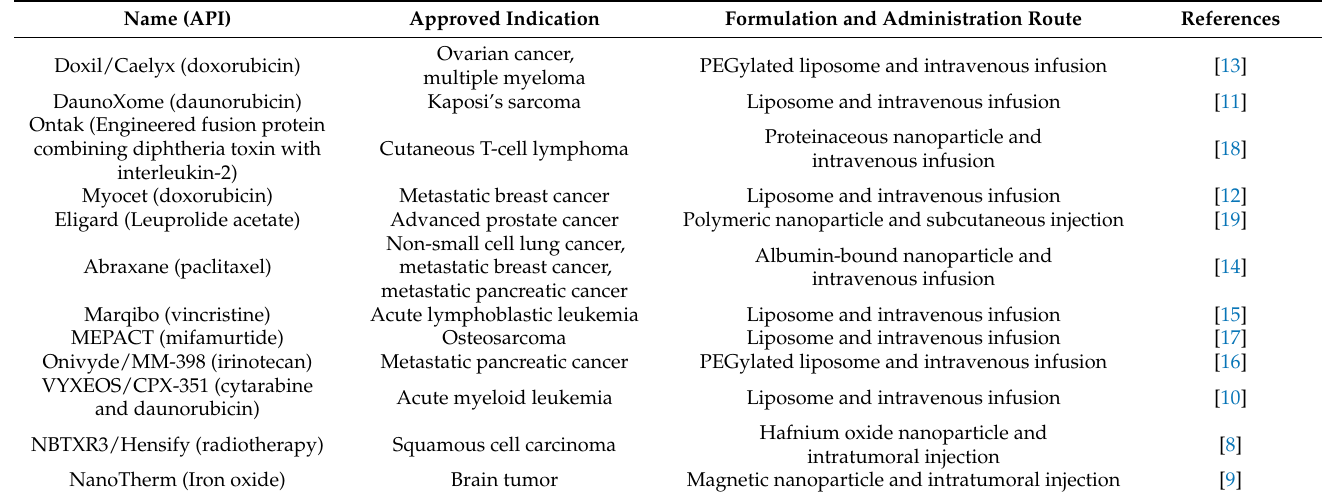
Figure 1. Molecular structures of doxorubicin, daunorubicin, leuprolide, paclitaxel, vincristine, mifamurtide, irinotecan, and cytarabine. Table 1. Pharmaceutical aspects of cancer nanomedicines approved by USA or